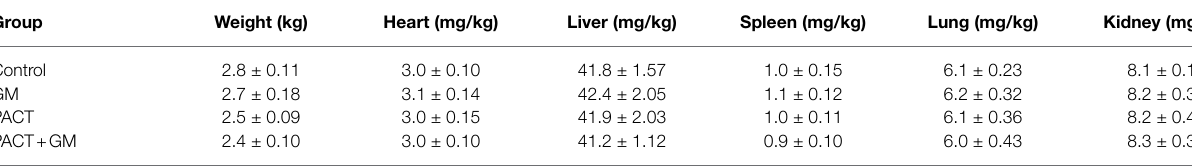
p > 0.05, indicates that the difference was not statistically